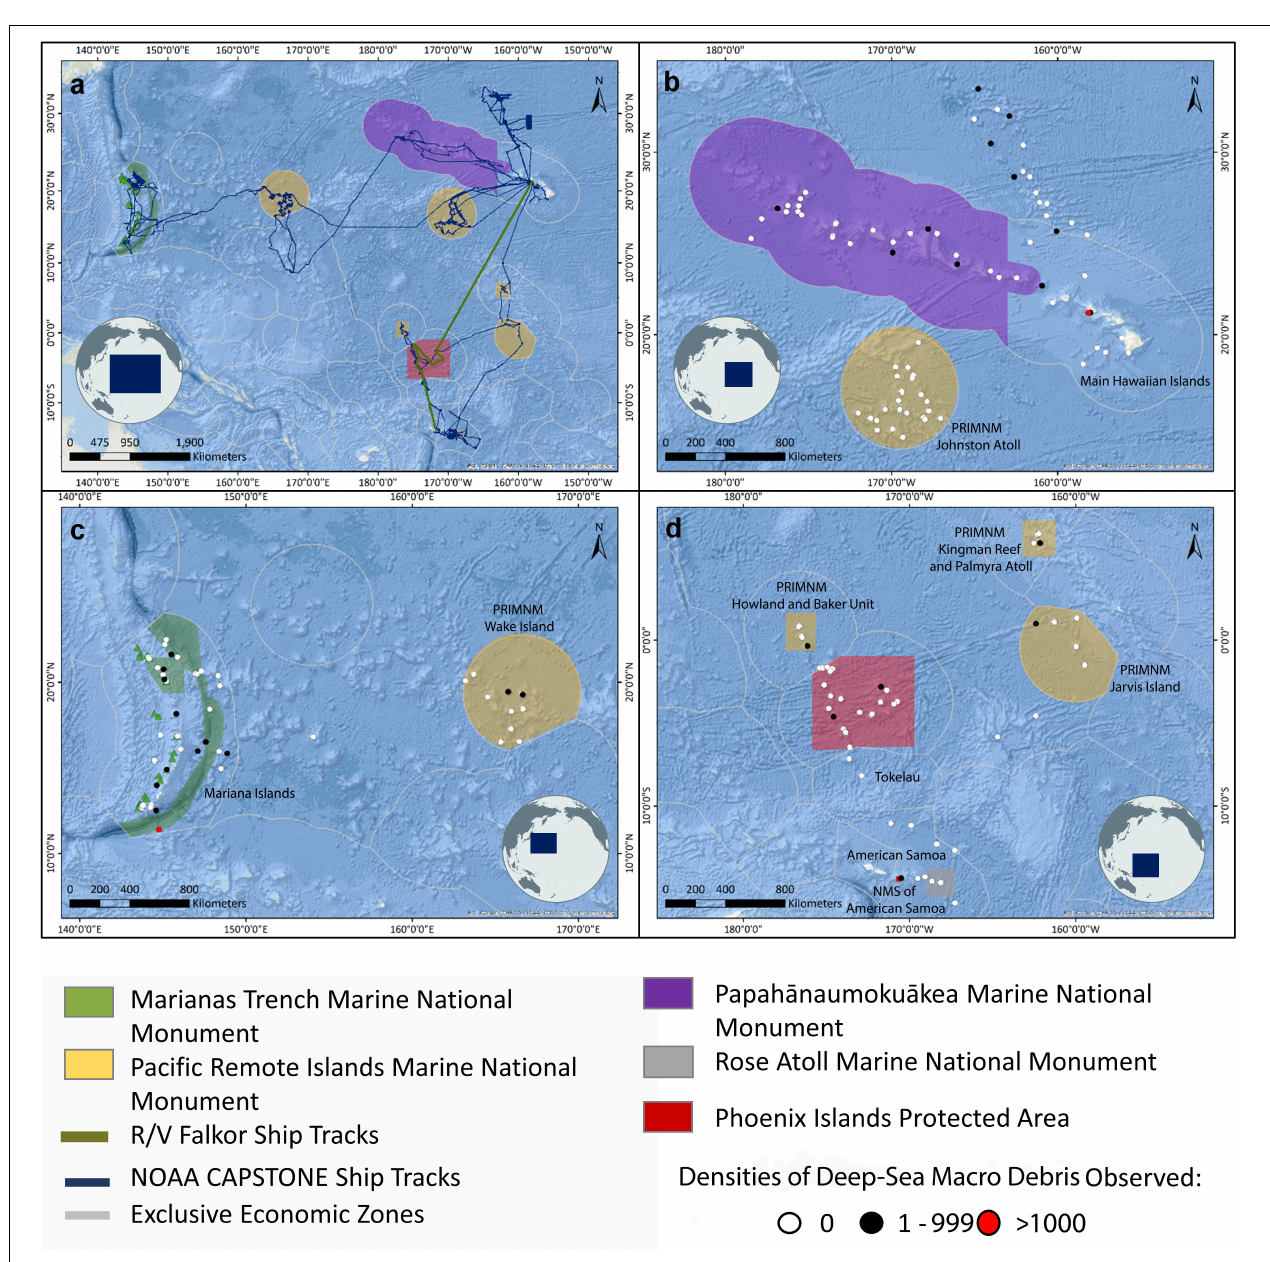
FIGURE 1 | Estimated deep-sea debris densities (items km − 2 ) from observations by ROVs in the central and western Pacific Ocean. (a) General footprint of NOAA Ship Okeanos Explorer cruises, adapted from Kennedy et al., 2019. (b) Estimated deep-sea debris densities in Papah¯anaumoku¯akea Marine National Monument, the main Hawaiian Islands, ABNJ, and the Johnston Atoll Unit of PRIMNM; (c) the Mariana Islands, Marianas Trench Marine National Monument, and the Wake Island Unit of PRIMNM; (d) American Samoa, NMS of American Samoa, Phoenix Islands Protected Area, Tokelau, ABNJ, and the Howland and Baker Islands, Kingman Reef and Palmyra Atoll, and Jarvis Island Units of PRIMNM. Green triangles in (c) are the volcanic unit of the Marianas Trench Marine National Monument. PRIMNM, Pacific Remote Islands Marine National Monument; NMS, National Marine